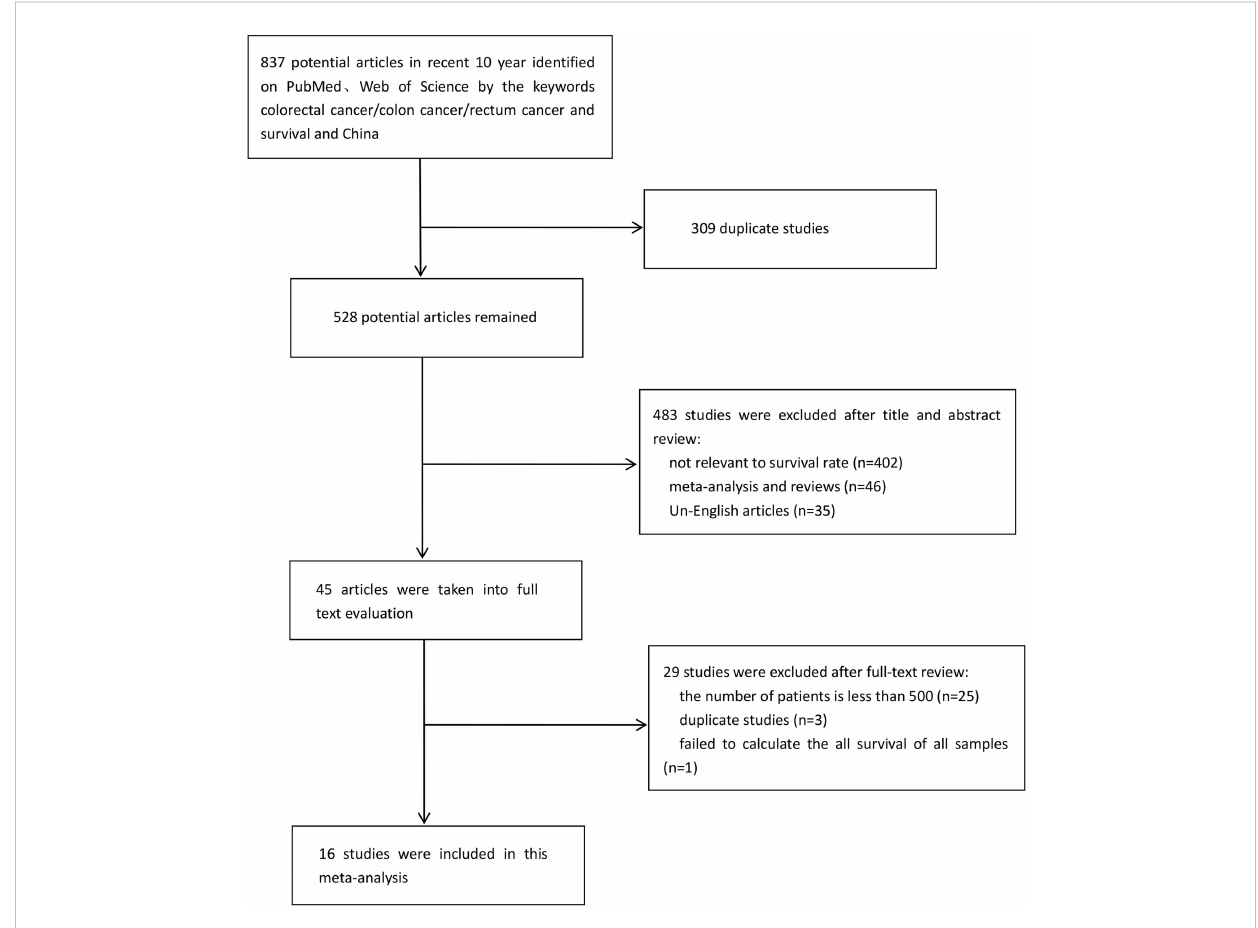
FIGURE 1 Flowchart of Search and Studies